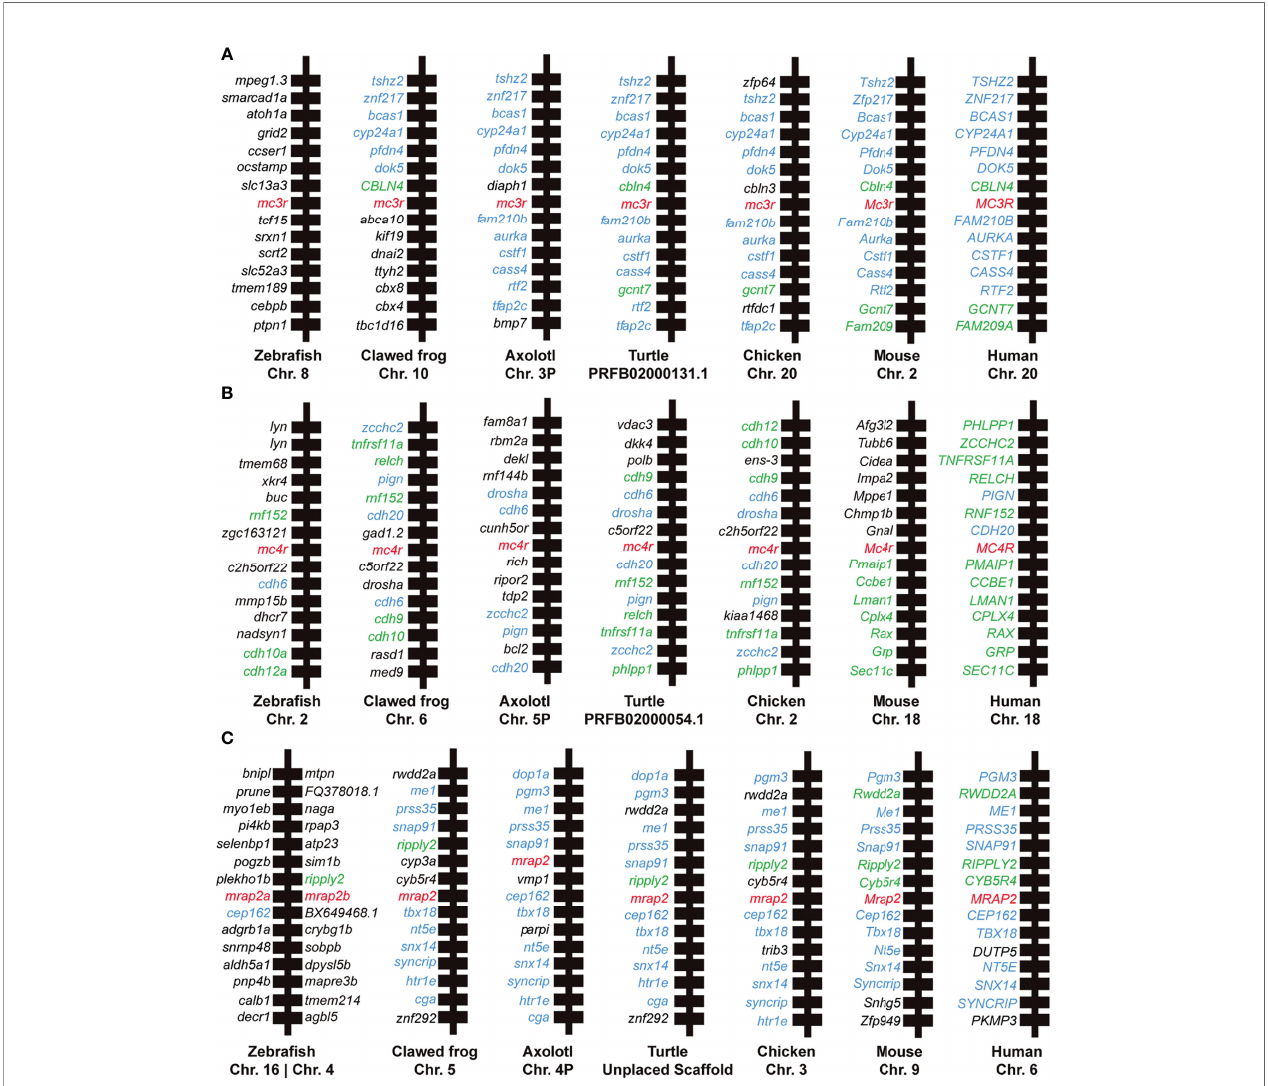
FIGURE 3 | Synteny analysis of mc3r , mc4r , and mrap2 . Chromosomal location and adjacent genes of (A) mc3r , (B) mc4r , and (C) mrap2 in following species: primate (Human, Macaque), ruminant (Cattle, Sheep), rodent (Mouse), avian (Chicken), reptile (Turtle, Snake, Common lizard), amphibia (Clawed frog, Axolotl), teleost (Zebra fi sh, Rainbow trout), and cartilaginous fi sh (Elephant shark). Genes showing conserved synteny with axolotl are shown in blue. Genes showing conserved synteny among at least two species but not with axolotl are shown in